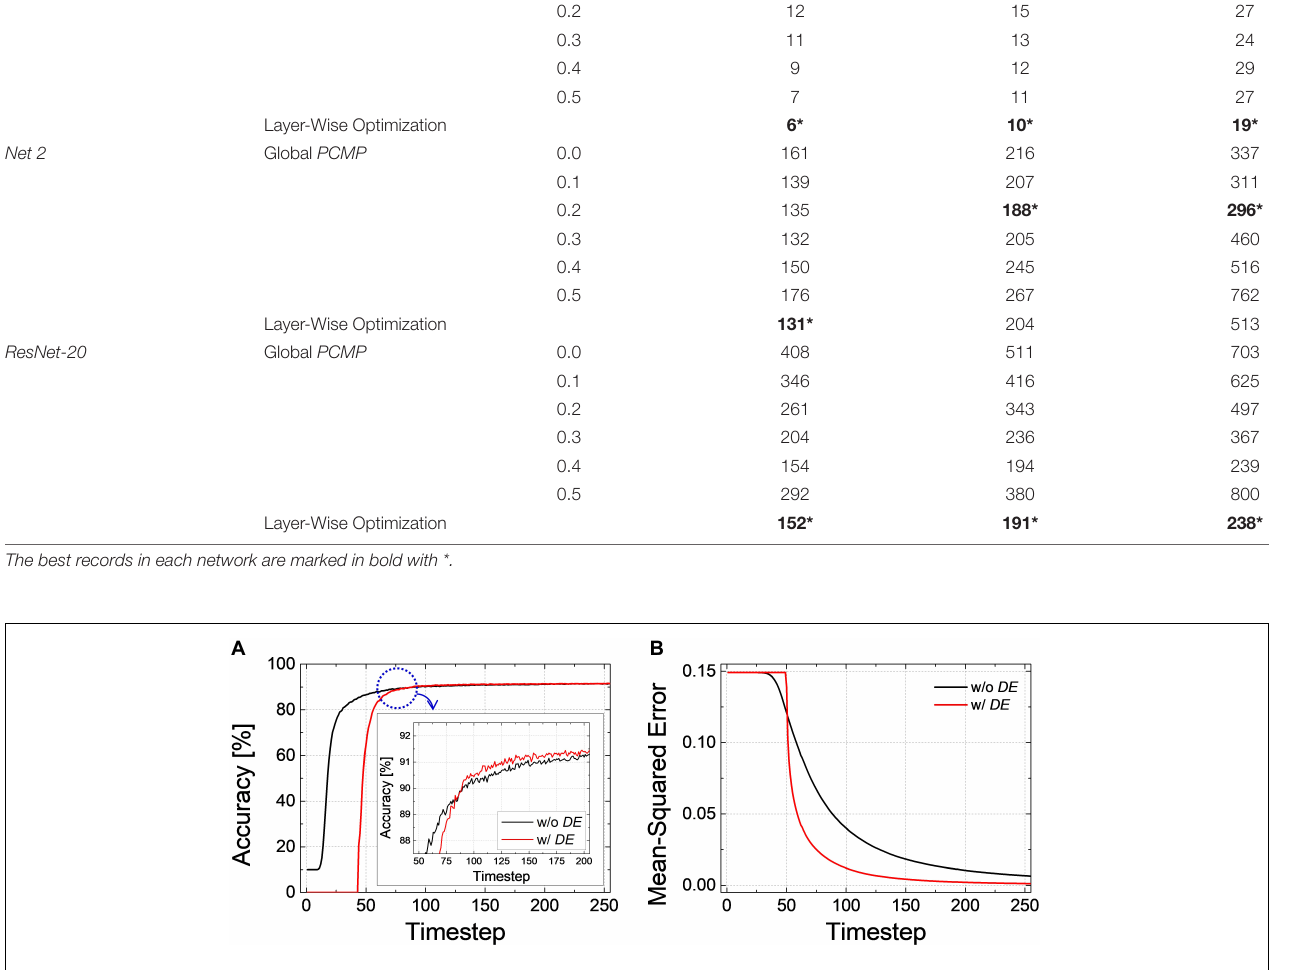
FIGURE 10 | (A) Accuracy-timestep curve of Net 2 with- and without DE . Both cases converge to the ANN’s performance, but the accuracy with DE converges faster than that without DE . (B) Changes of MSE with respect to the simulation timestep for Net 3 with- and without DE . MSE with DE decreases and approaches zero much faster than that without DE